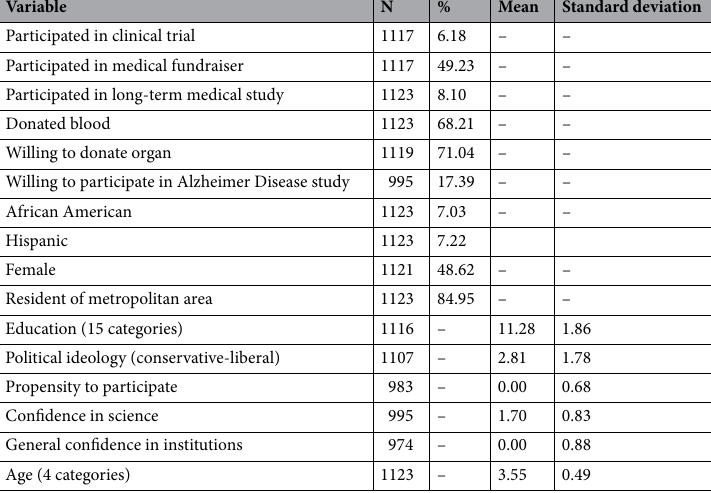
Table 1. Descriptive statistics for TAPS survey respondents at least 45 years